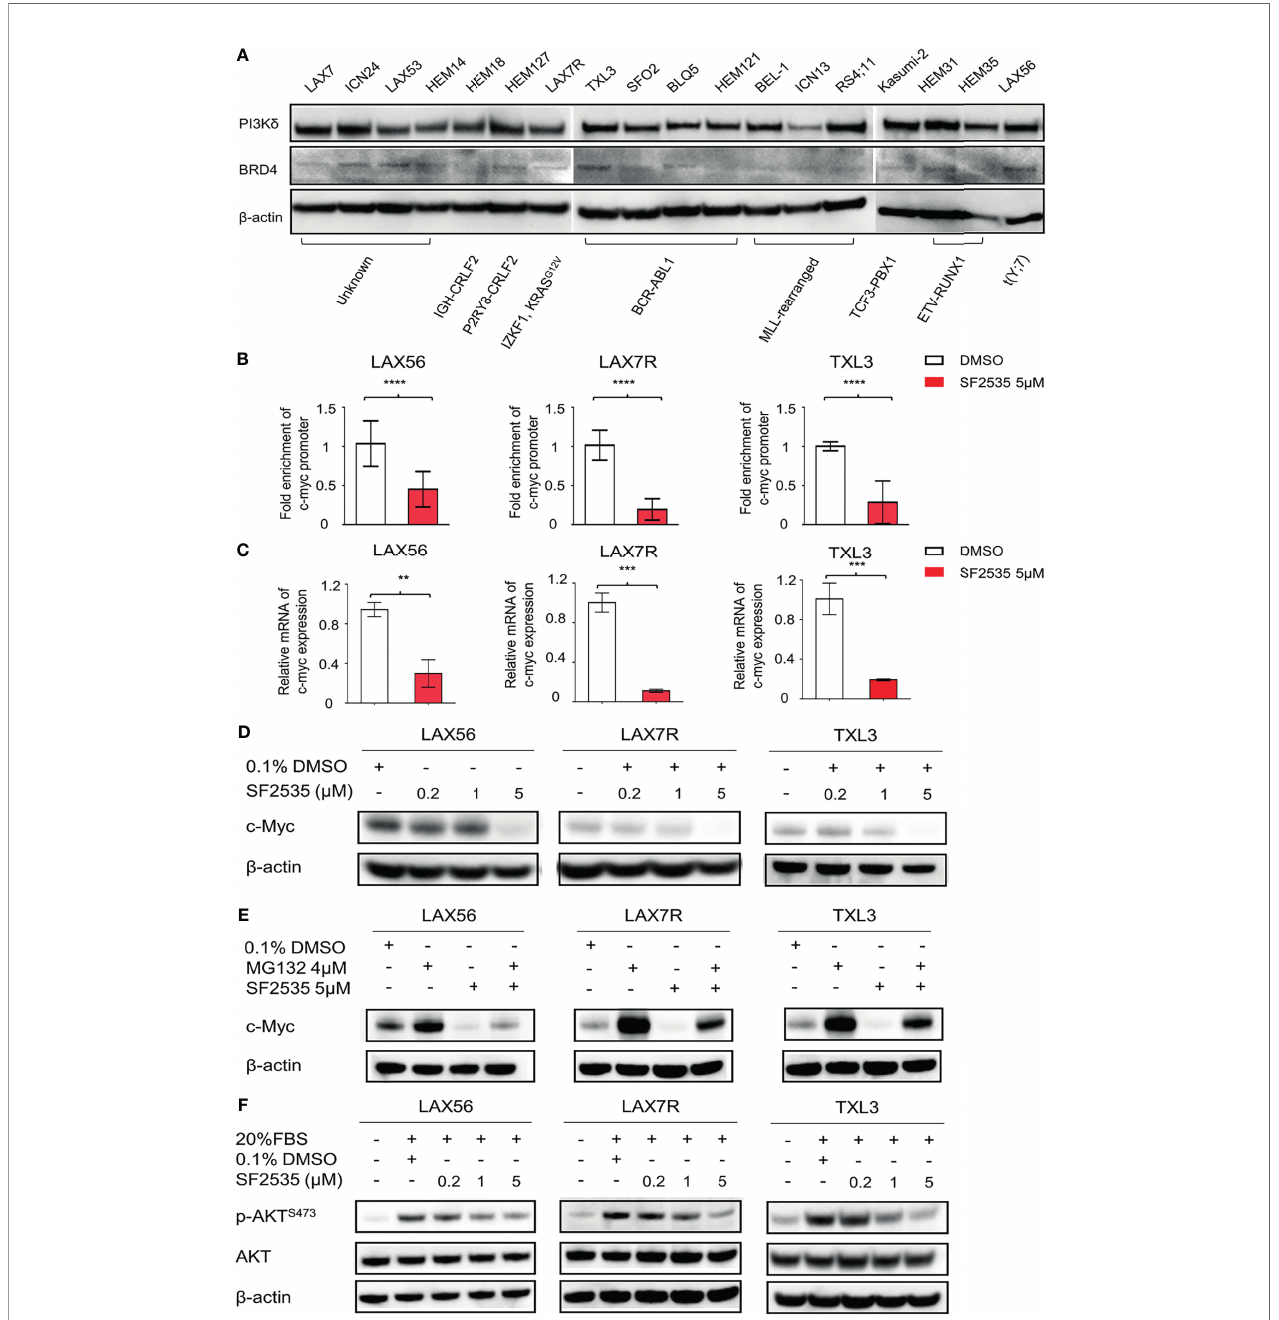
FIGURE 1 | SF2535 downregulates c-Myc and p-AKT. (A) PI3K d and BRD4 expression in whole cell lysates in B-ALL. (B) Primary B-ALL LAX56, LAX7R and TXL3 cells were treated with SF2535 at 5µM. After 18 hours, the cells were harvested for BRD4 ChIP analysis which was performed at the c-Myc promoter site. Data were combined from three independent experiments per leukemia. Data was analyzed by paired Student ’ s t-test, where ****P<0.0001 vs. ctrl (DMSO). (C) qPCR data showing the effect of SF2535 on c-Myc expression in B-ALL cells. Experiment was performed in triplicate. Data was analyzed by Student ’ s t test, where **P<0.01, ***P<0.001 vs. ctrl (DMSO). (D) LAX56, LAX7R and TXL3 cells were treated with 0.1% DMSO or SF2535 (0.2 m M, 1 m M, or 5 m M) for 48 hours. c-Myc expression of B-ALL cells was analyzed by Western blot. (E) LAX56, LAX7R, and TXL3 cells were pre-treated with either 0.1%DMSO control or proteasome inhibitor MG132 (4 m M) for 45 min and subsequently treated with SF2535 at 5 m M for 6 hours. c-Myc expression was analyzed by Western blot. (F) LAX56, LAX7R and TXL3 cells were cultured in MEM- a without serum overnight. Subsequently, cells were treated with 0.1% DMSO control, SF2535 (0.2 m M, 1 m M, 5 m M) for 30 mins. Cells were activated with 20% FBS for 1 hour. Western blots of p-AKT S473 and AKT are shown. b -actin was used as internal control for equal protein loading for Western blots (D – F) . One of two independent experiments per leukemia was performed for (D – F)